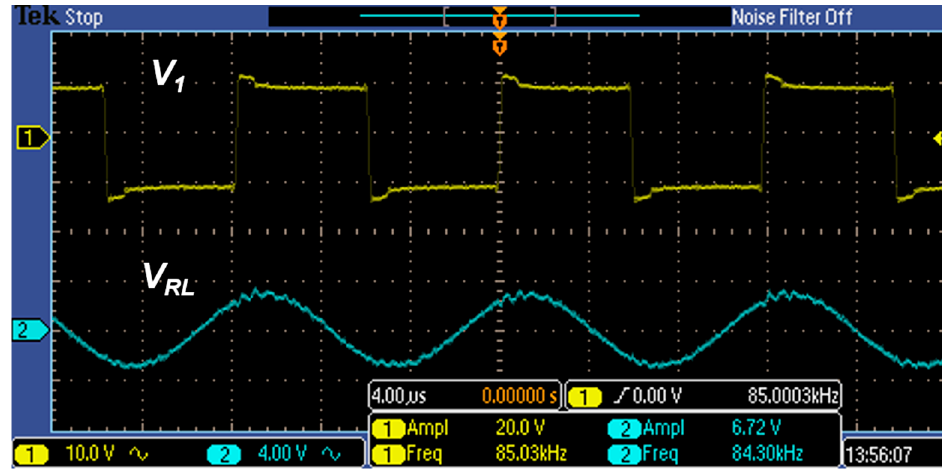
Figure 5. Experimental result for WPT evaluation.